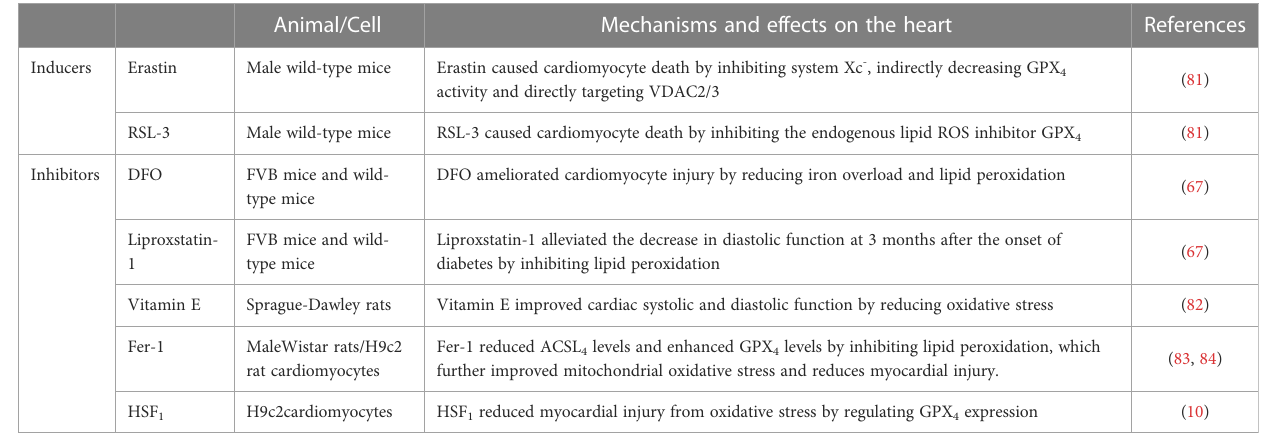
TABLE 2 Potential applicationsof ferroptosis inducers and inhibitors in DCM. Animal/Cell Mechanisms and effects on the